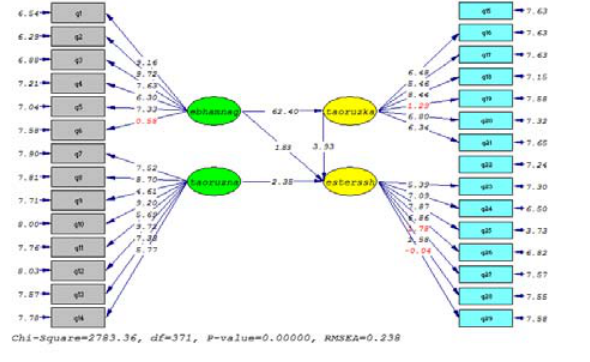
Fig. 4. Model significance test and determining the confirmed paths based on structural equation